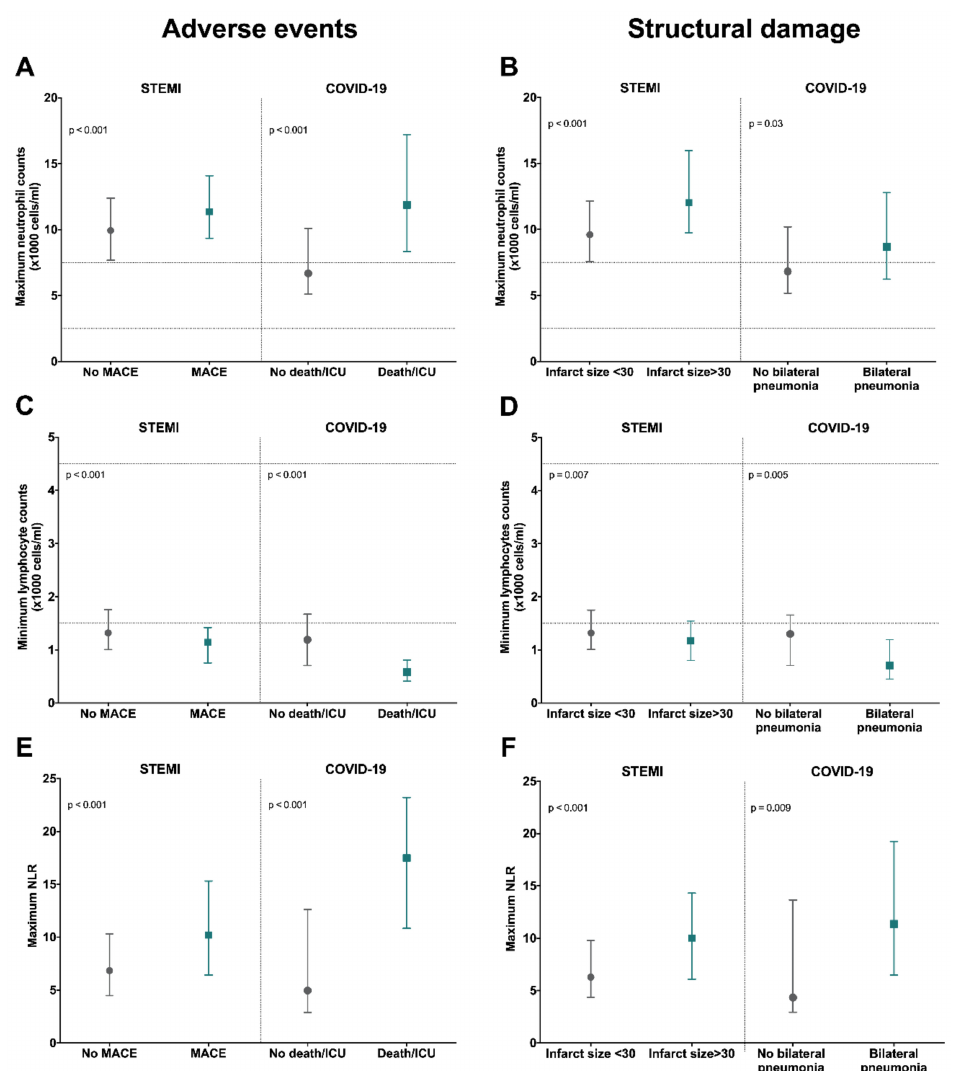
Figure 7. Association of maximum neutrophil and minimum lymphocyte count as well as maximum NLR with occurrence of adverse events and severe structural damage. Maximum neutrophil count ( A , B ), minimum lymphocyte count ( C , D ), and maximum NLR ( E , F ) as related to presence of adverse events (left panel) or severe structural damage (right panel). In STEMI patients, MACE included death and / or readmission for heart failure, whereas in the COVID-19 cohort, death and / or admission in ICU were regarded as adverse events. With respect to structural damage, STEMI patients were dichotomized according to CMR-derived infarct size and COVID-19 depending on the presence of bilateral pneumonia in either chest X-ray or CT images. Data were expressed as median [quartile 25-quartile 75]. Dotted lines represent the upper and lower ranges of normality. CMR: cardiac magnetic resonance; COVID-19: coronavirus disease 2019; CT: computed tomography; ICU: intensive care unit; MACE: major adverse cardiac events; NLR: neutrophil-to-lymphocyte ratio; STEMI: ST-segment elevation myocardial